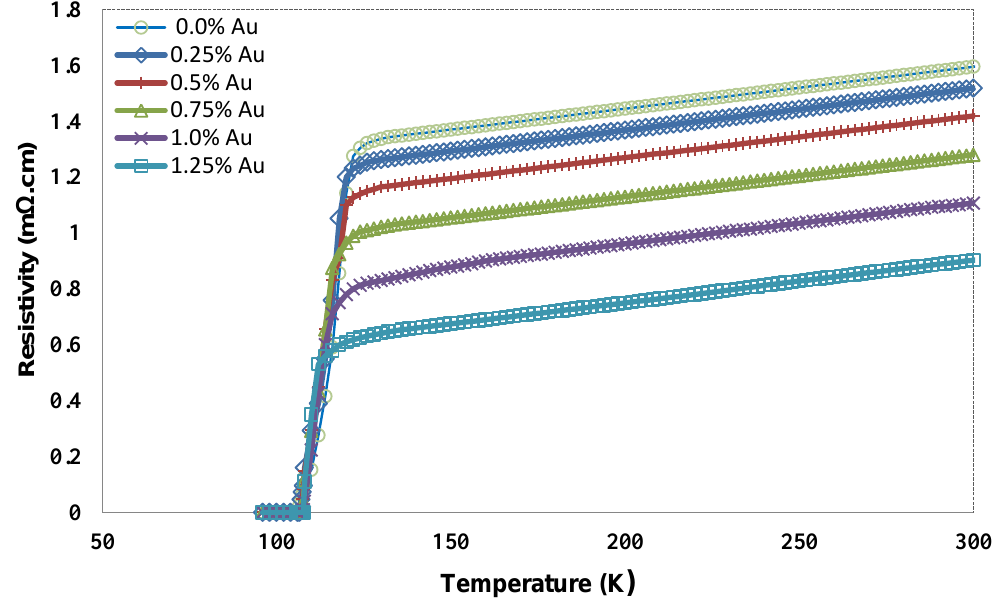
Fig. 3: ρ-T plots of (Au) Table 2: The residual resistivity ρ width ∆𝑻 and Jc of (Au) 𝒄 (Au-NPs)